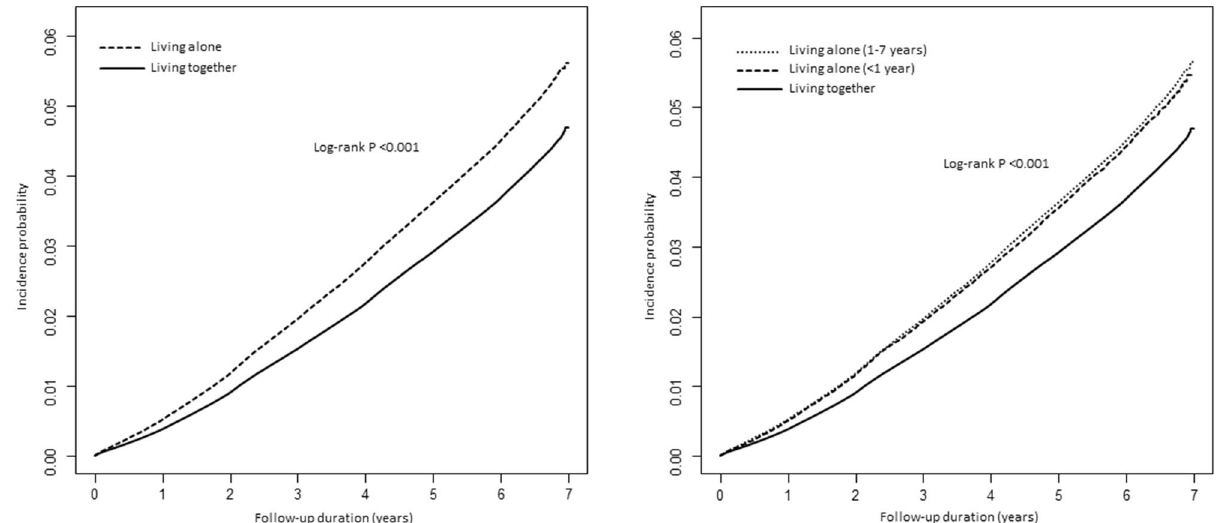
Figure 2. Kaplan–Meier curves for incidence probability of type 2 diabetes according to living